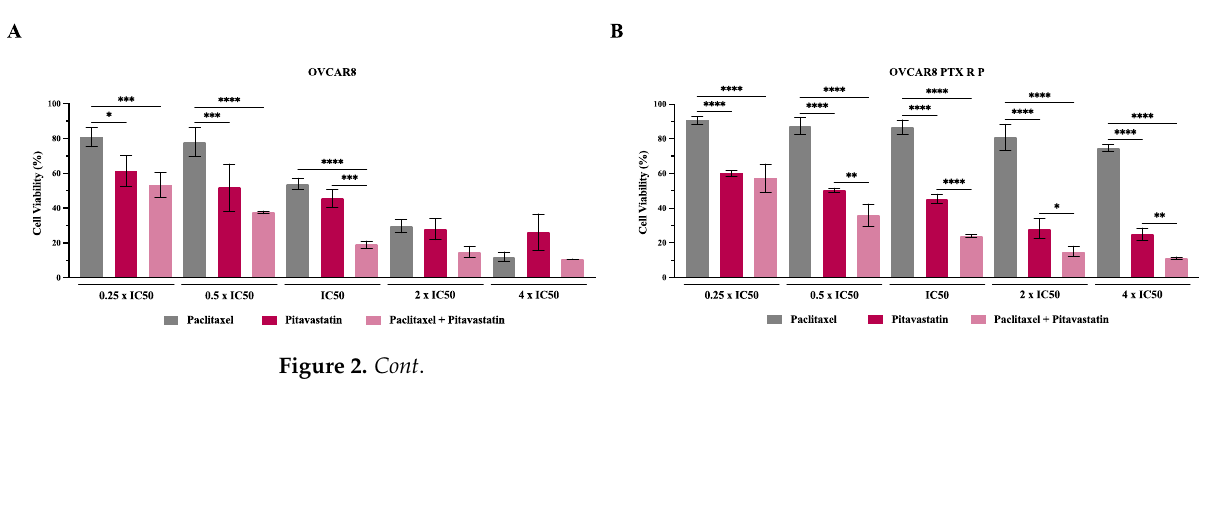
Figure 2. Repurposed drugs increase the efficacy of Paclitaxel in reducing cellular viability of chemoresistant high ‐ grade serous carcinoma cells. ( A – J ) Bar charts showing cell viability of